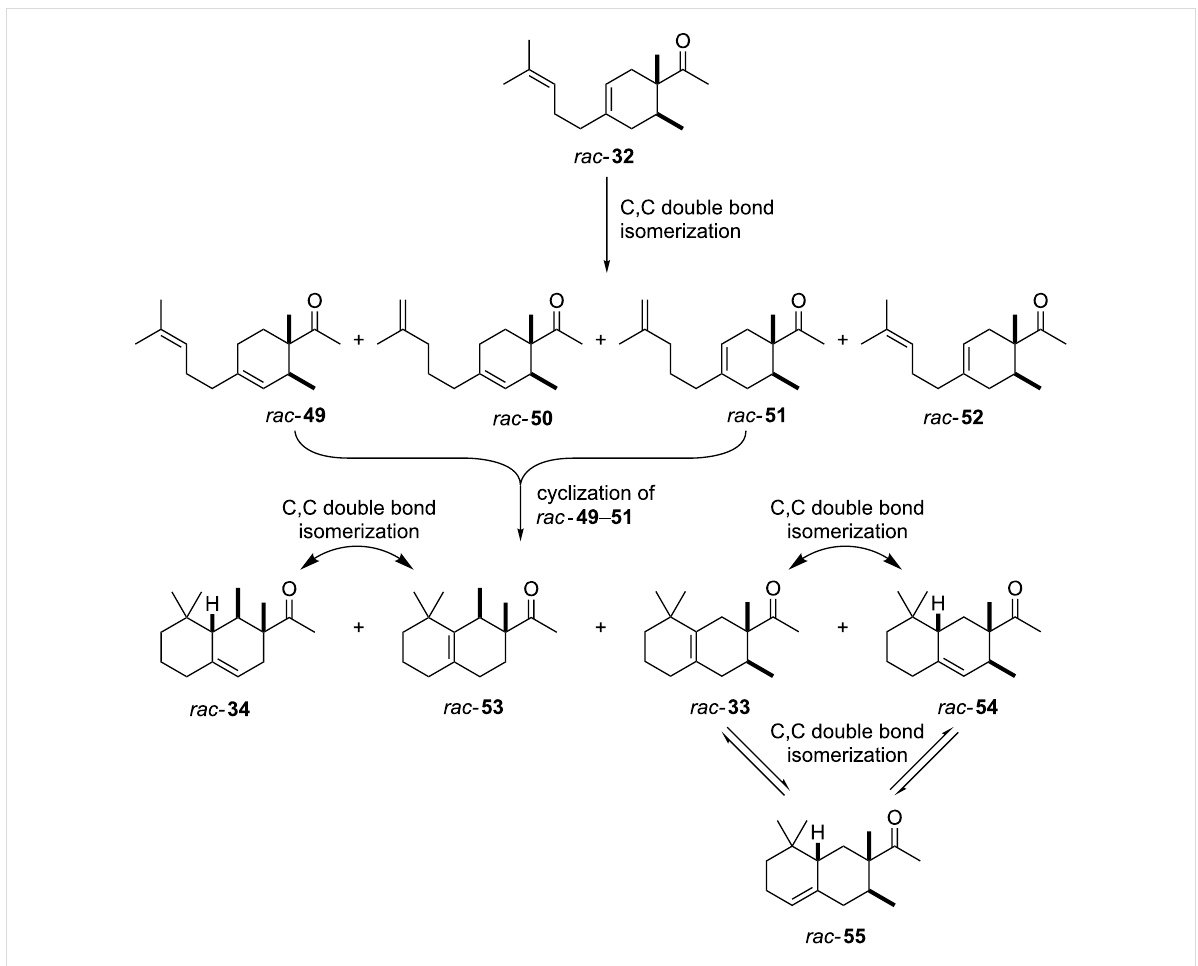
Scheme 7: Analysis of the isomerisation process and formation of products. Most importantly, Iso E Super ® ( 33 ), Iso E Super Plus ® ( 34 ) and Iso Gamma ( 55 ) are formed [1]. All compounds are obtained as racemates